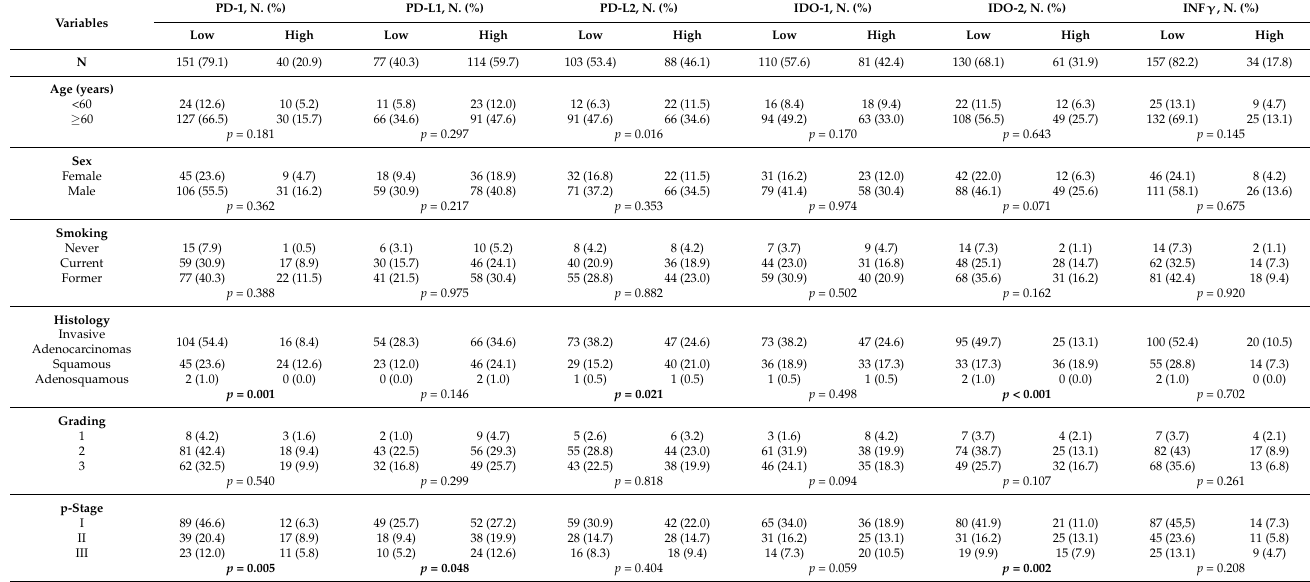
Table 2. Clinicopathological variables of patients according to PD-1, PD-L1, PD-L2, IDO-1, IDO-2, INF γ gene expression levels.